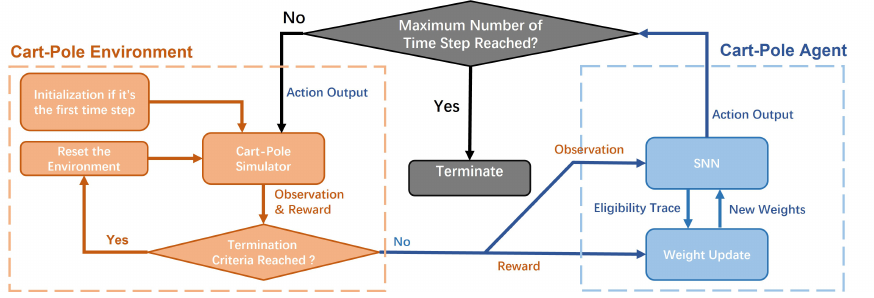
Figure 3. A general workflow of the training process using